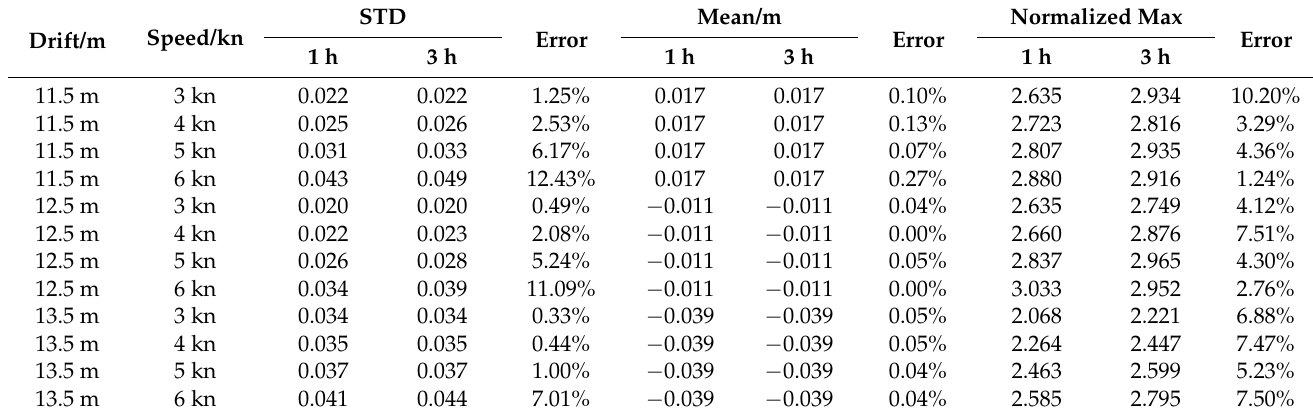
Table 4. Heave at different simulation times.